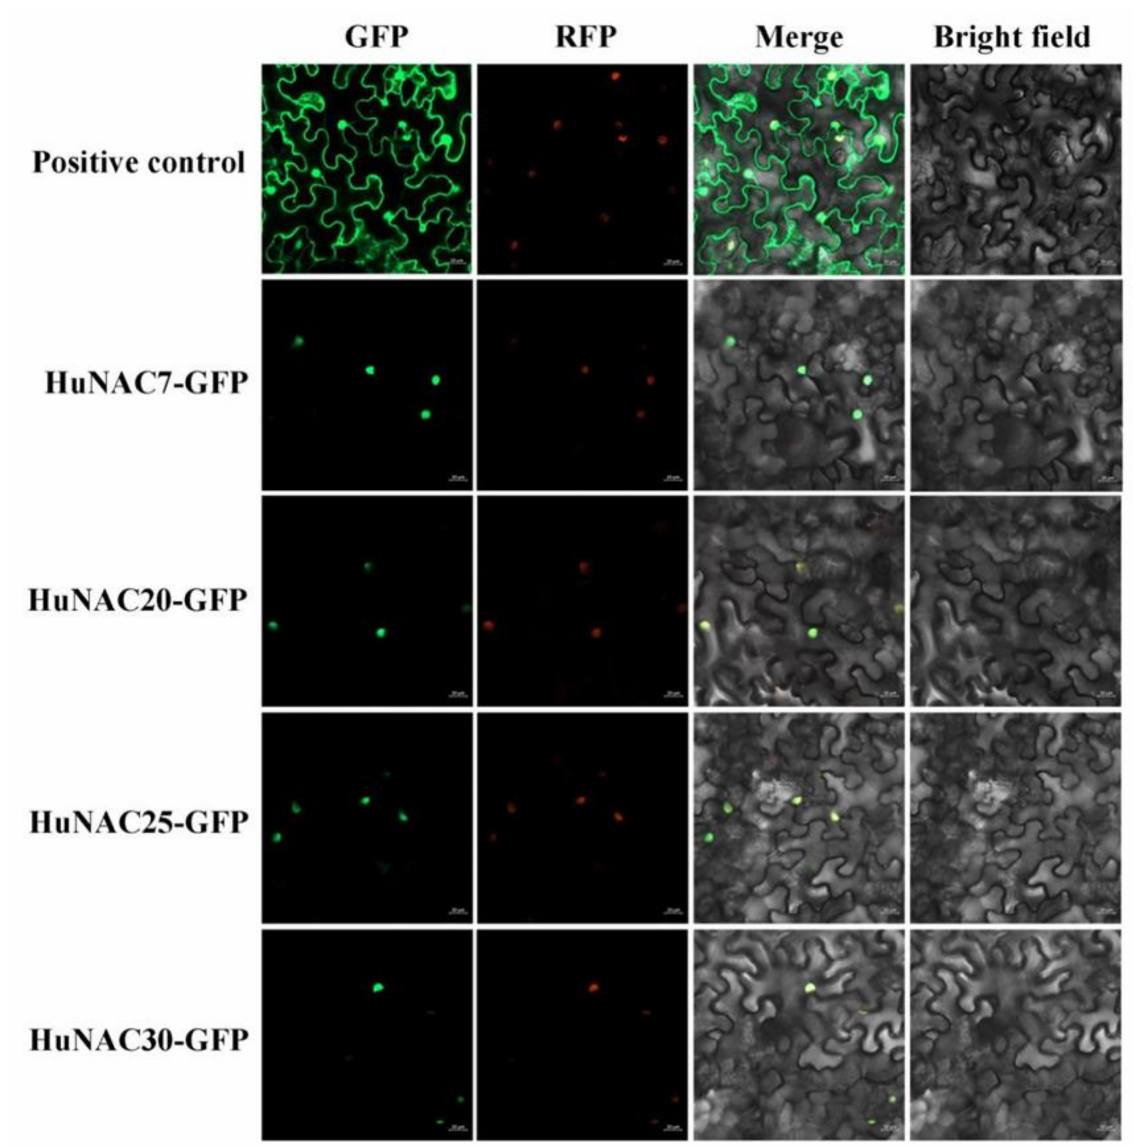
Figure 6. Subcellular localization of HuNACs in Nicotiana benthamiana leaves. The fusion protein and GFP-positive control were transiently expressed in N. benthamiana leaves by Agrobacterium tumefaciens strain GV3101 (pSoup-p19), respectively. Bars = 20 µ